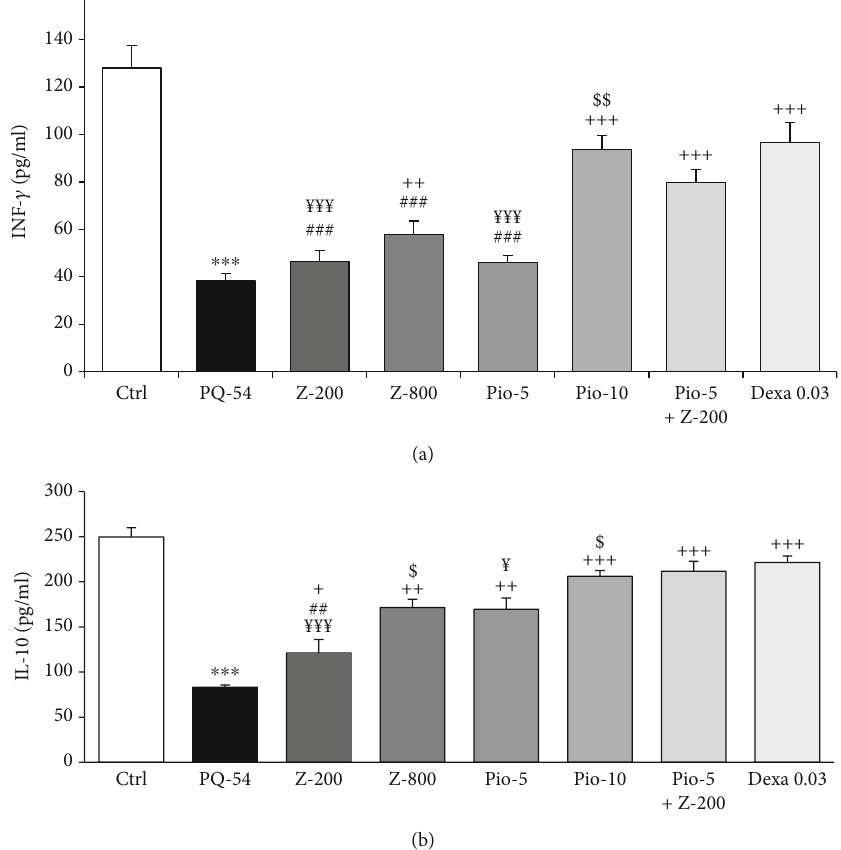
Figure 5: Values of interferon gama (INF- γ ) (a) and interleukin-10 (IL-10) (b) in the serum of control group (Ctrl), group exposed to paraquat aerosol at doses of 54 mg/m 3 (PQ-54), and groups exposed to PQ-54mg/m 3 and treated with 5 and 10 mg/kg/day pioglitazone, 200 and 800 mg/kg/day Zataria multi fl ora , 0.03mg/kg/day dexamethasone, and 5 mg/kg/day pioglitazone + 200 mg/kg/day Zataria multifl ora (Pio-5, Pio-10, Z-200, Z-800, Dexa 0.03, and Pio- 5 + Z -200, respectively). The results are expressed as the mean ± SEM ( n = 6 in each group). ∗∗∗ p < 0 : 001 compared to the control group. + p < 0 : 05 , ++ p < 0 : 01 , and +++ p < 0 : 001 compared to the PQ group. ## p < 0 : 01 and ### p < 0 : 001 compared dexamethasone treatment with other treated groups. $ p < 0 : 05 and $$ p < 0 : 01 compared to low dose of Zataria multi fl ora and pioglitazone groups. ¥¥¥ p < 0 : 001 comparison between Pio ‐ 5mg/kg + Z ‐ 200mg/kg with low dose of Zataria multi fl ora and pioglitazone groups. ¥ p < 0 : 05 and ¥¥¥ p < 0 : 001 compared to Pio ‐ 5 mg/kg + Z ‐ 200 mg/kg group. Comparisons between di ff erent groups were made using one-way ANOVA followed by Tukey ’ s multiple comparison